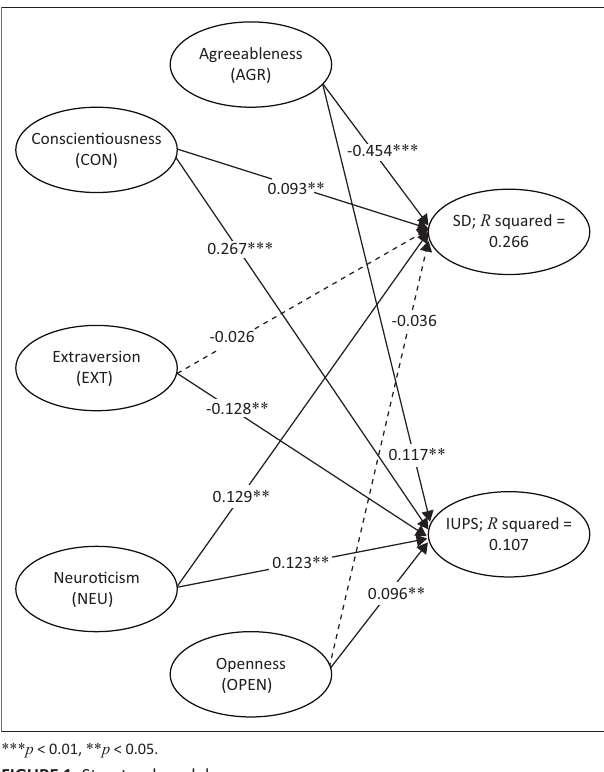
FIGURE 1: Structural